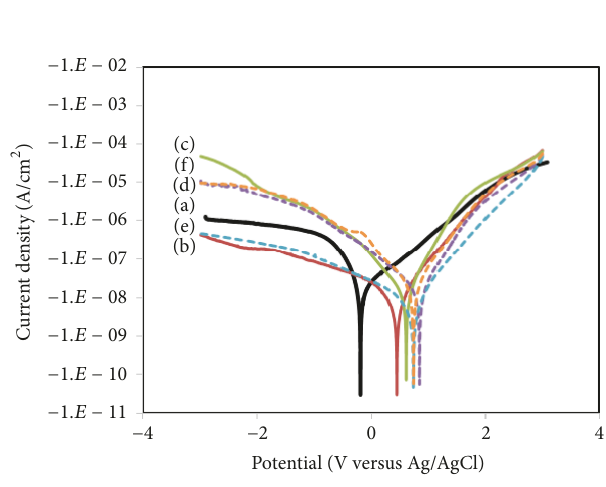
Figure 4: Potentiodynamic polarization of (a) pure DLC, (b) Si- 14:1:2, and (f) Si-N-DLC